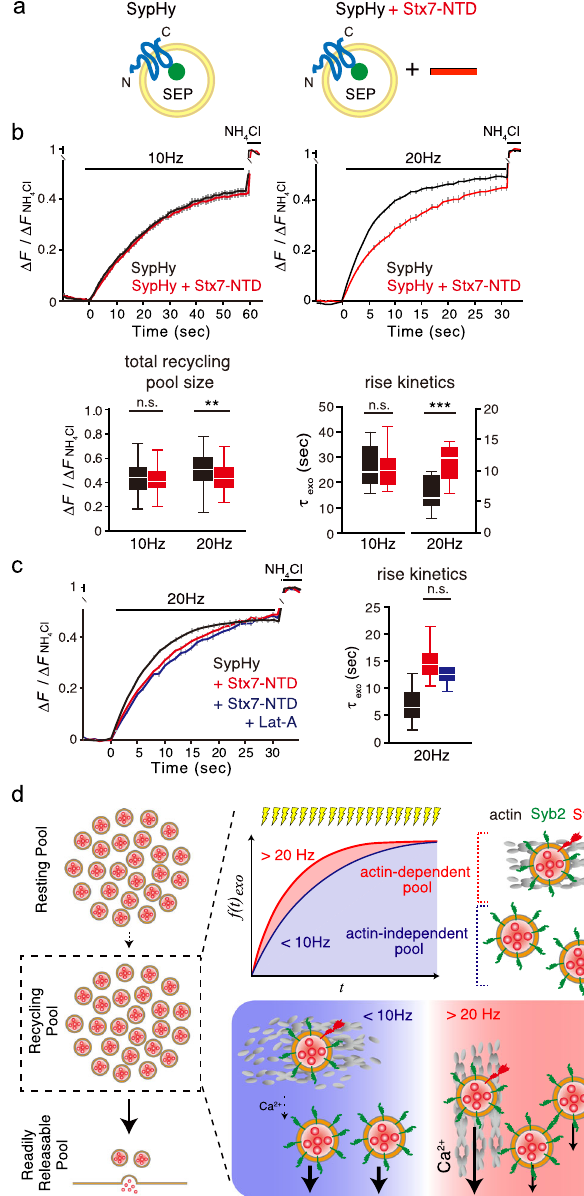
Fig. 7 Overexpression of Stx7-NTD slowed SypHy responses only during HFS. a Schematic diagram of SypHy and SypHy co-expressed with Stx7- NTD. Stx7-NTD was placed after a P2A sequence so that all SypHy-positive cells co-expressed Stx7-NTD. b The total recycling pool monitored by SypHy responses in the absence (black) and presence (red) of Stx7-NTD at 10 Hz, 600APs (left) and 20 Hz, 600APs (right) after ba fi lomycin treatment. Bottom box-whisker plots show quanti fi cation of total recycling pool sizes (left) and time constants of rise time (right, τ exo ). c Pretreatment with Lat-A did not further reduce release kinetics upon Stx7-NTD overexpression. Responses of SypHy with Stx7-NTD in the presence of Lat- A (blue) were compared with control (SypHy only, black) and SypHy with Stx7-NTD (red) in response to at 20 Hz, 600APs. A box-whisker plot shows time constants of the rise time ( τ exo ). SypHy responses with Stx7- NTD (red) and Stx7-NTD + Lat-A (blue) did not differ signi fi cantly ( p > 0.05). d Schematic summary of this study, depicting that Stx7 is preferentially present in the rapidly replenishing SV pool during intense, repetitive